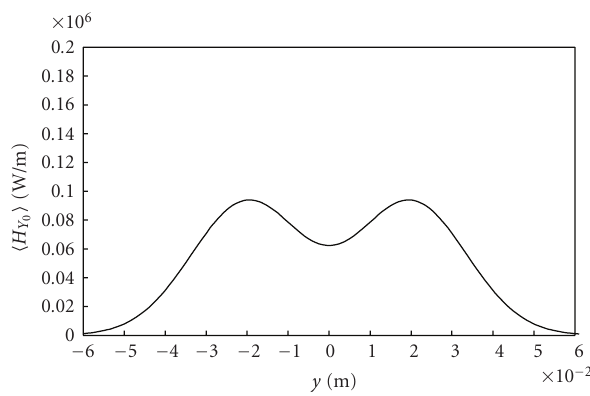
Figure 14: Heat flux distribution in the arc driven by a rectangular magnetic field. Y 0 is assumed as 2 . 2 × 10 − 2 m.